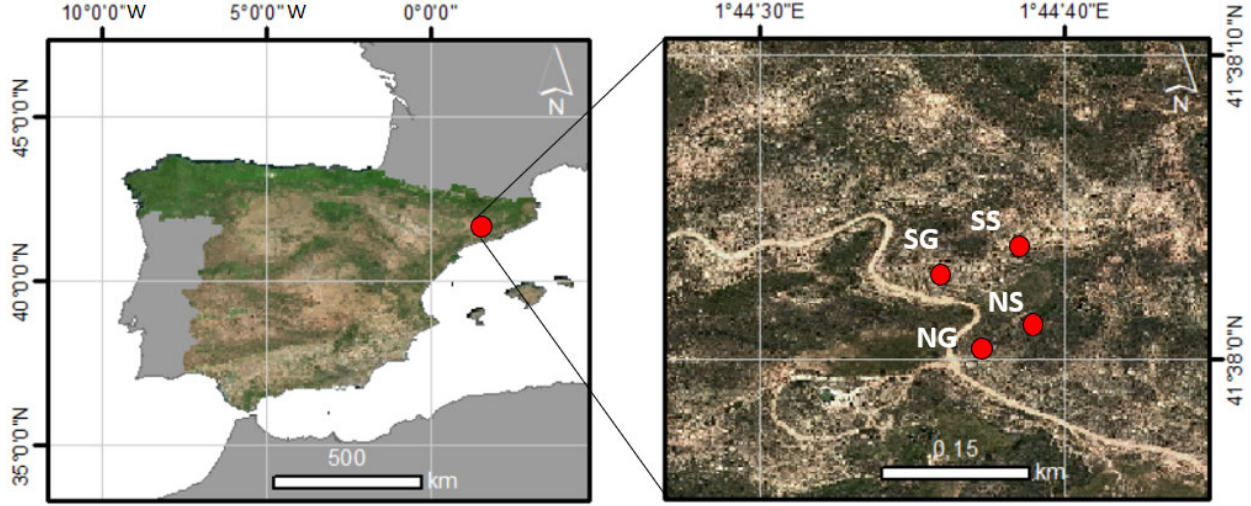
Figure 1. Location of the studied soil profiles in the Iberian Peninsula. SS–south aspect/steep slope; NS–north aspect/steep slope; NG–north aspect/gentle slope; SG–south aspect/gentle slope.